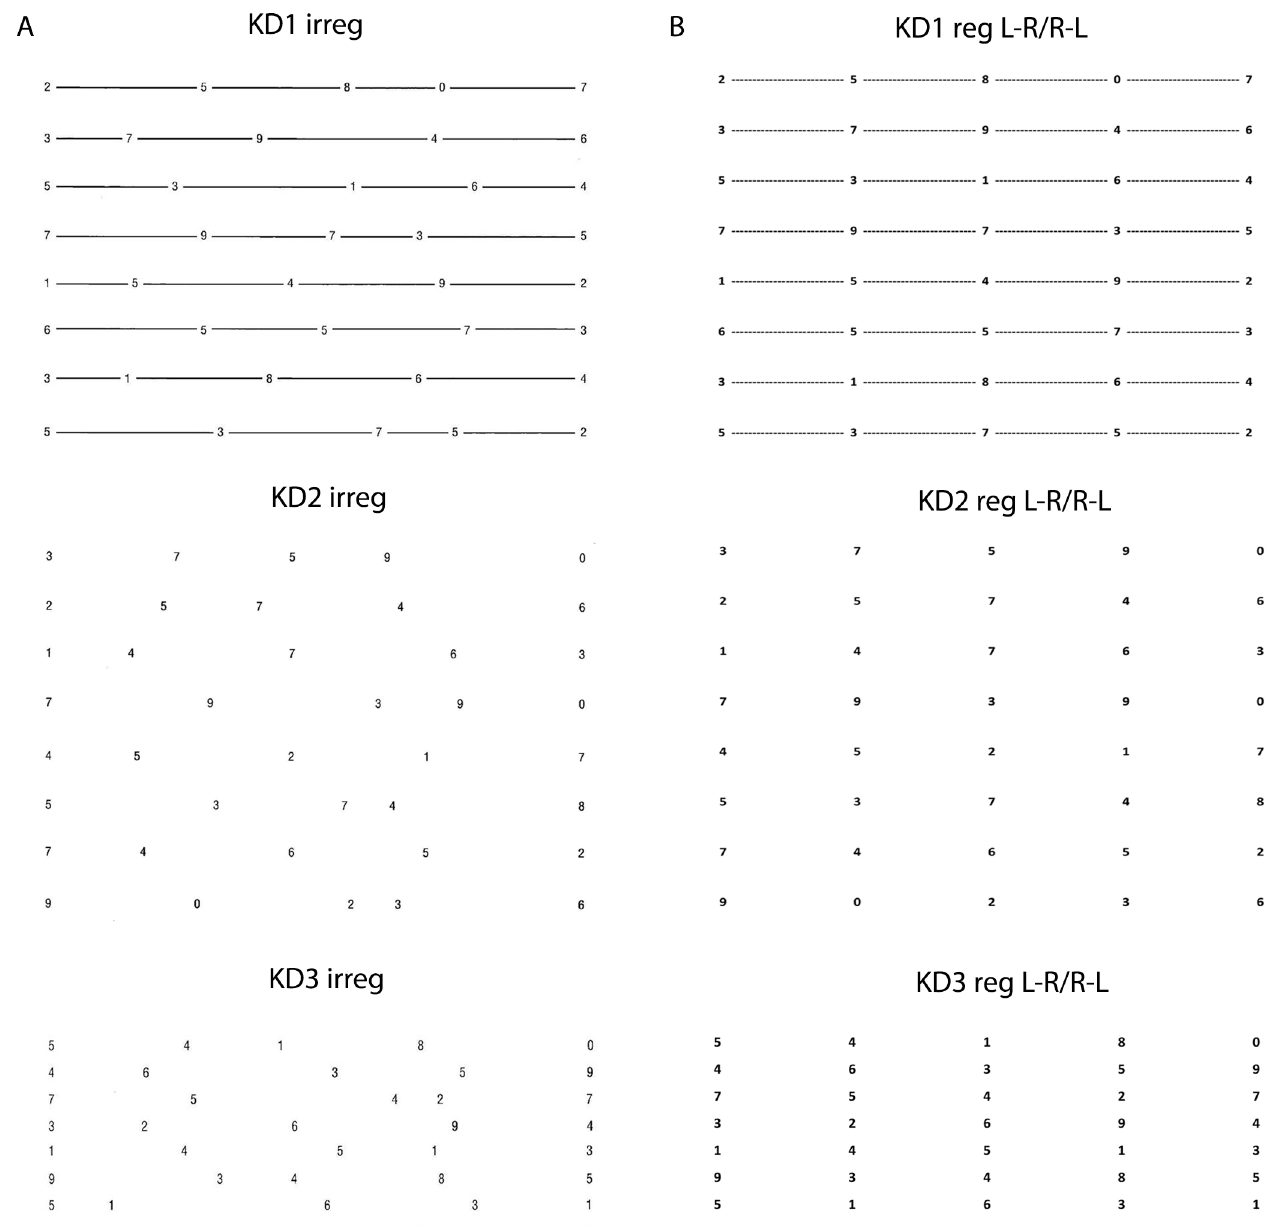
Fig 1. Irregularly (A) and regularly (B) spaced single digit number reading tests. The irregularly spaced tests (KD1 irreg, KD2 irreg, and KD3 irreg) were read left-to-right twice. Then the regularly spaced tests (KD1 reg, KD2 reg, and KD3 reg) were read left-to-right (L-R) and then right-to-left (R-L). KD1 has a horizontal line to help guide reading from one number to the next, although that adds some visual crowding. KD2 has the same spacing as KD1 but has no lines to guide reading. KD3 has less vertical space between the lines compared with KD2 and therefore has the most amount of visual